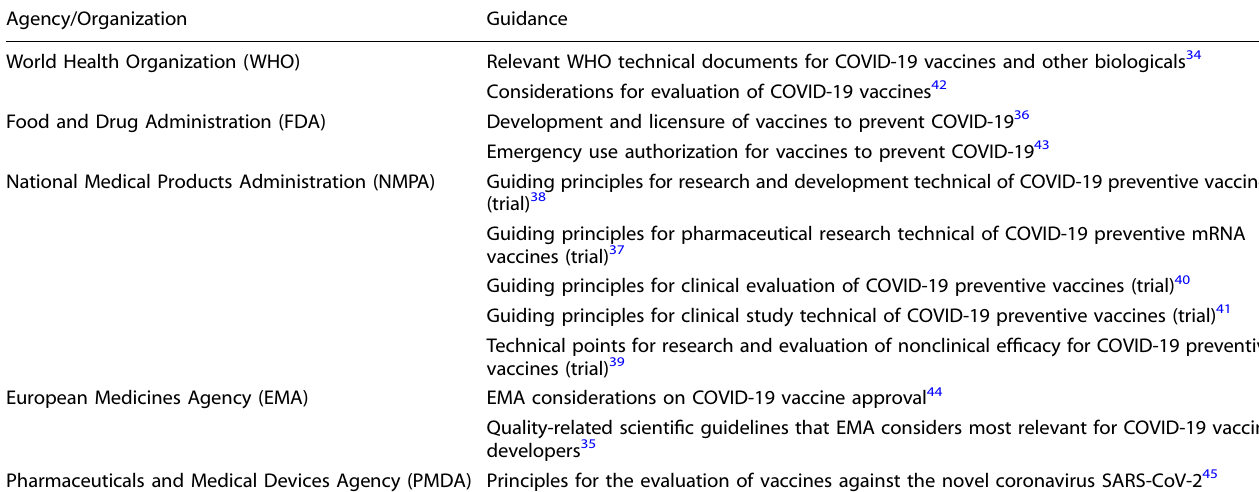
Table 2. Technical guidelines for the research and development of COVID-19 vaccines published worldwide Agency/Organization